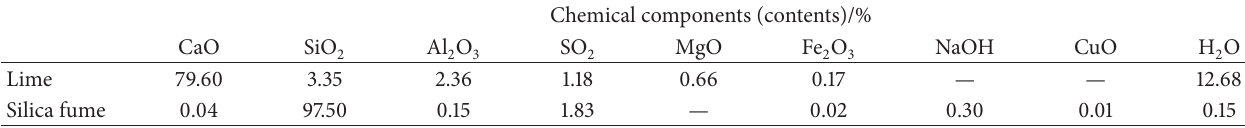
Table 1: Chemical components of silica fume and